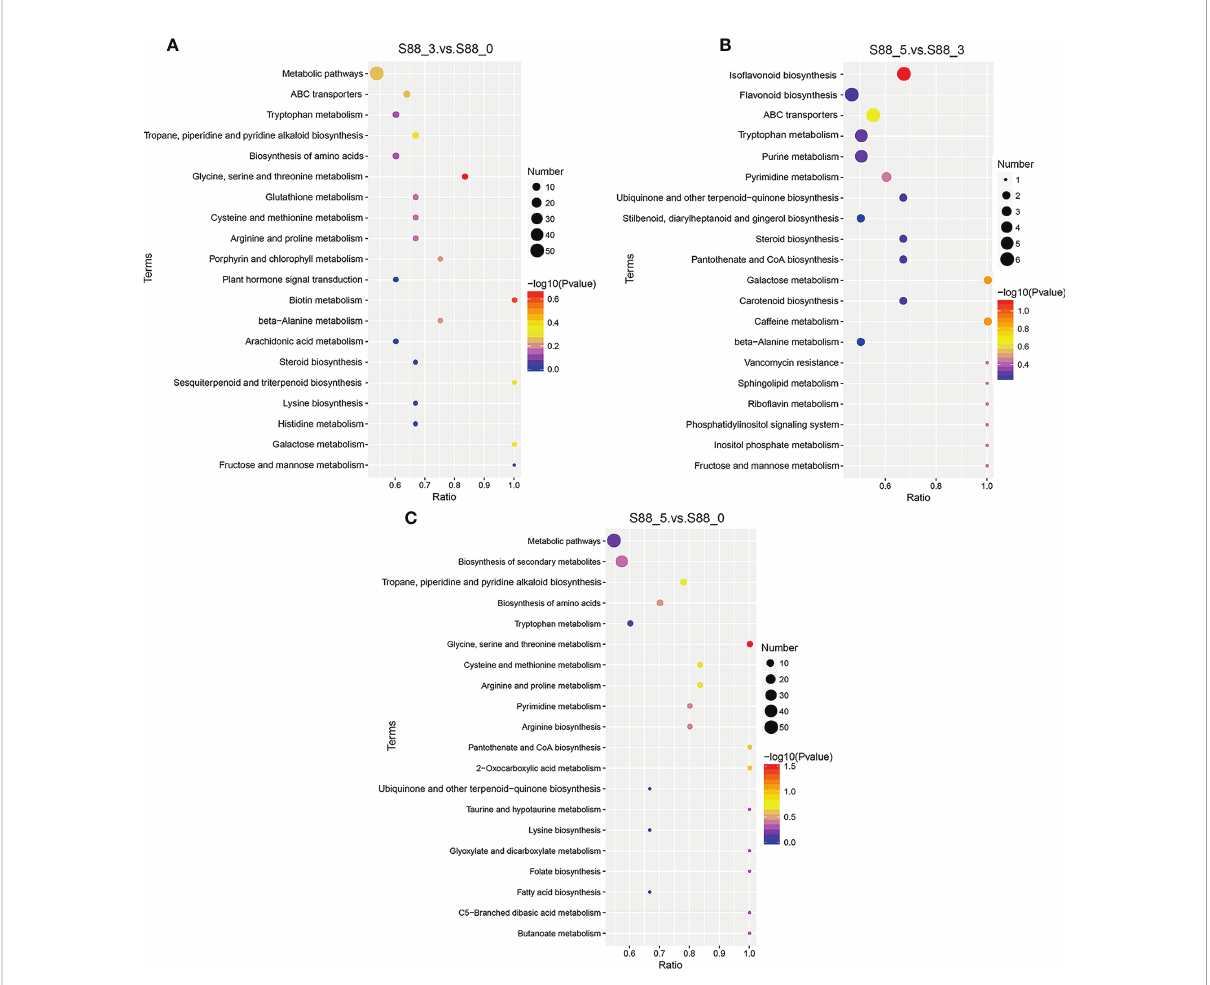
FIGURE 7 Top 20 KEGG pathways enriched in different comparison groups over the F. fujikuroi inoculation time. (A – C) are the scatter plots of the enrichment statistics of the KEGG pathway in S88_3.vs.S88_0, S88_5.vs.S88_3, and S88_5.vs.S88_0, respectively. The abscissa in the fi gure is x/ y (the rate of the number of differential metabolites in the corresponding metabolic pathway to the total number of metabolites identi fi ed in the pathway), and the larger the values indicate, the higher the enrichment of differential metabolites in the pathway. The color of the dot represents the p-value of the hypergeometric test, and the smaller the values stand for, the greater the reliability of the test and the more statistically signi fi cant. The size of the dot represents the number of different metabolites in the corresponding pathway. The larger the dot indicates the more differential metabolites in the